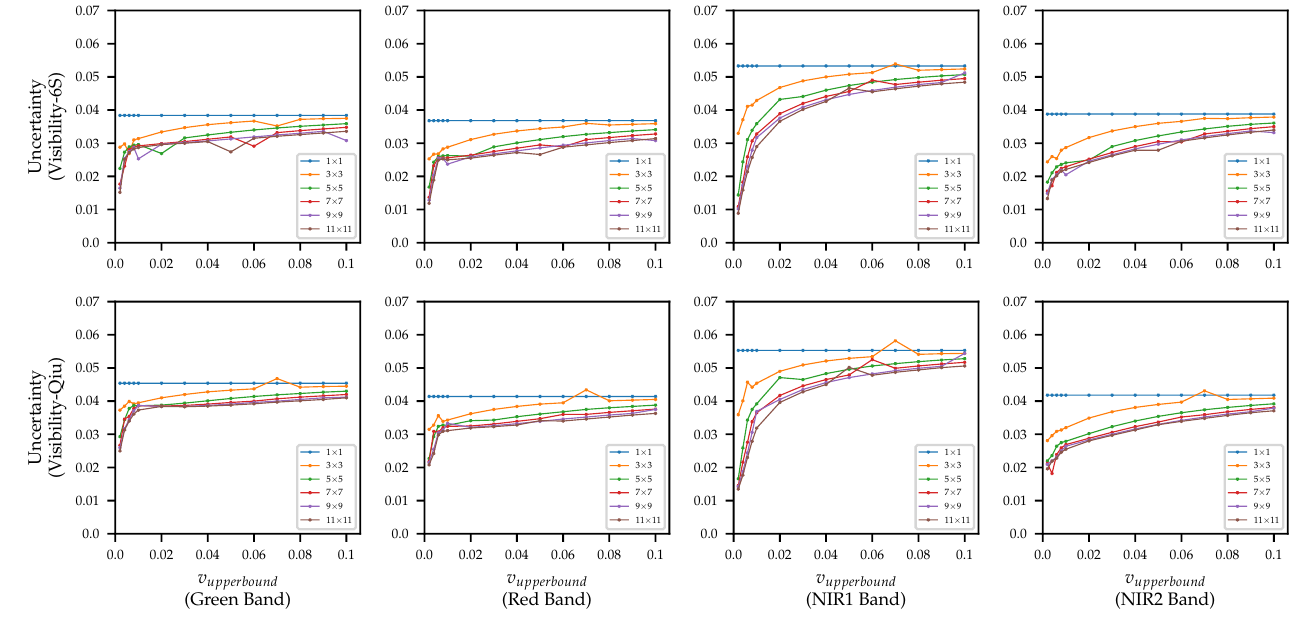
Figure 7. Relationship between v upper bound and uncertainty with different receptive field.